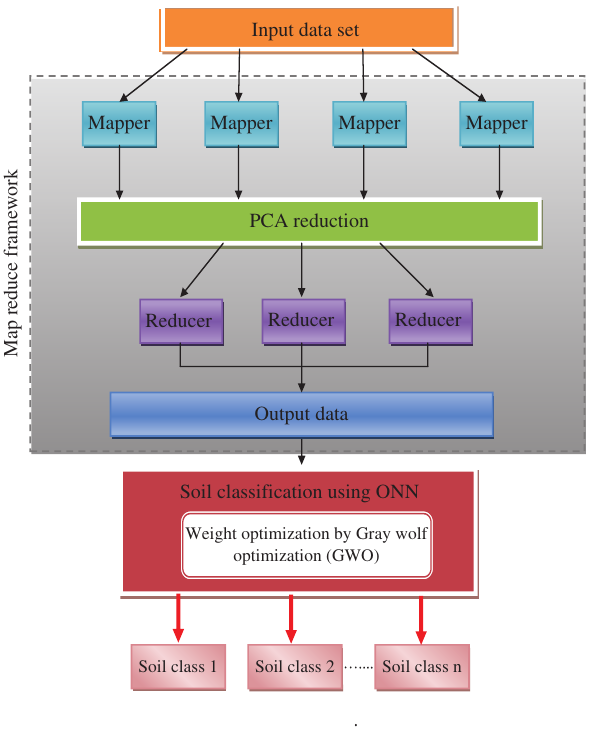
Figure 1: Semantic Structure of the Recommended